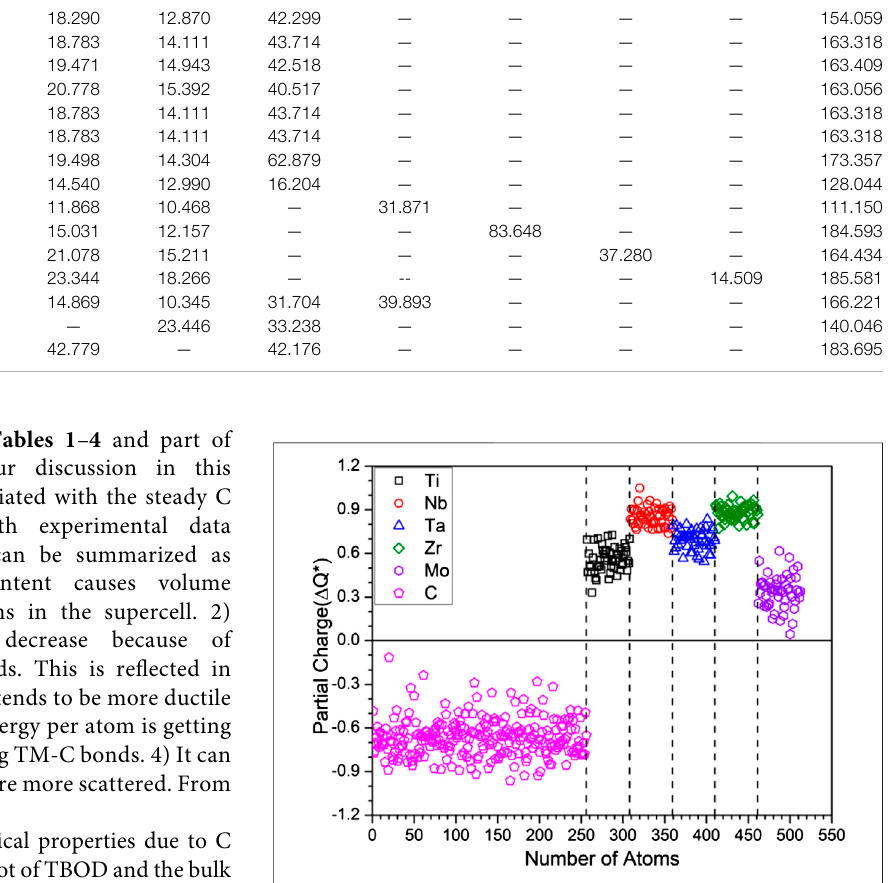
FIGURE 3 | Partial Charge distribution of